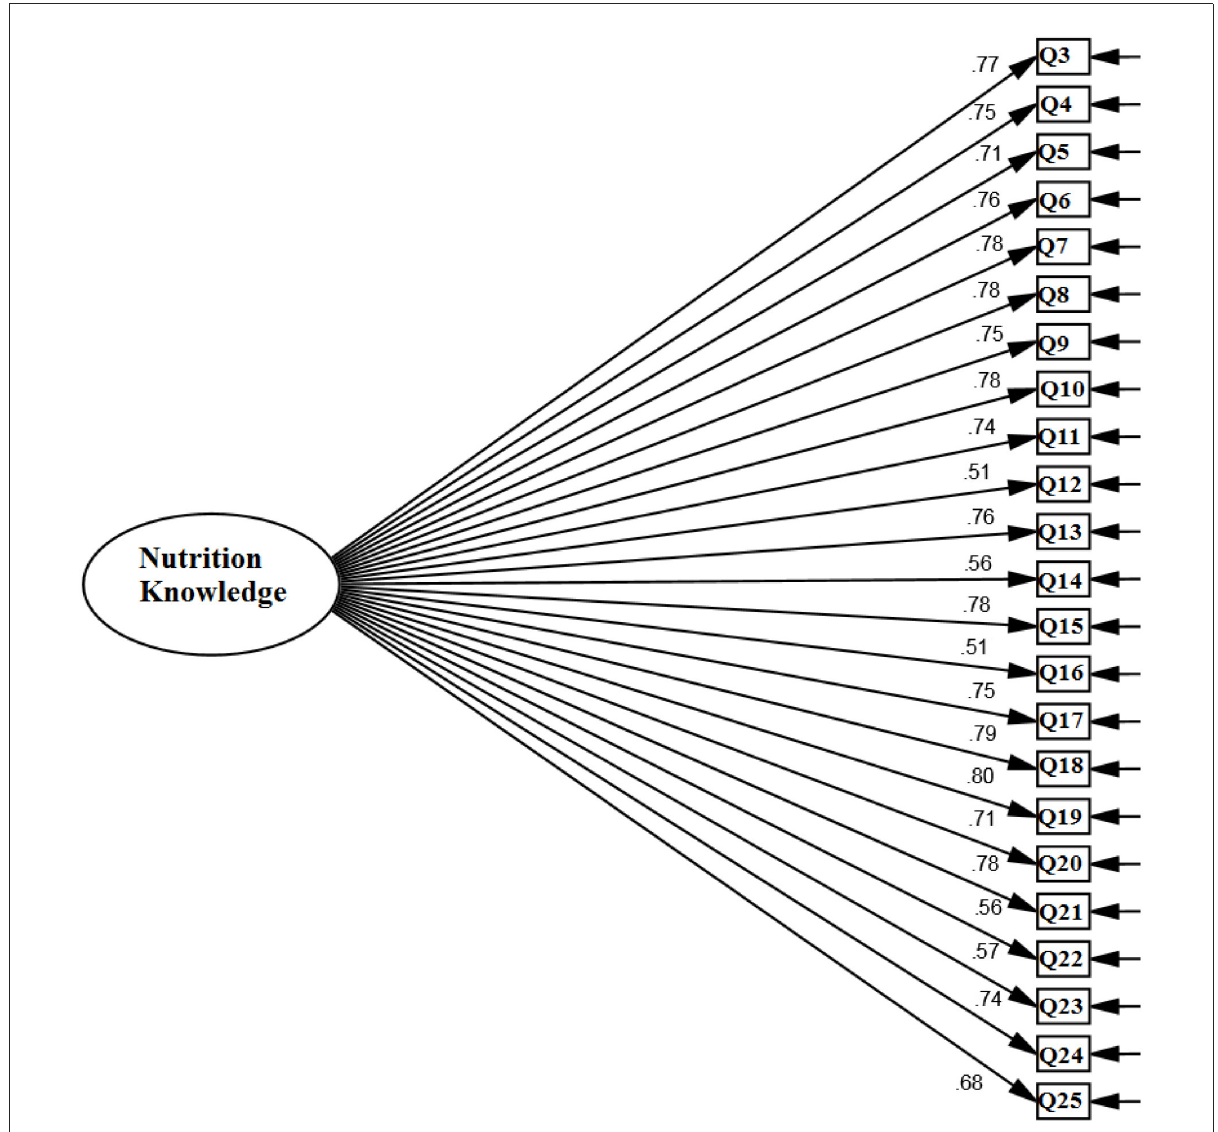
FIGURE2 Confirmatory factor analysis of the nutrition beliefs scale.